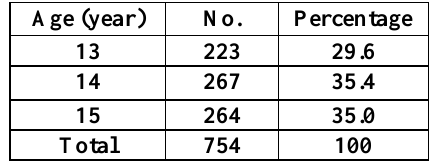
Table 1: Distribution of the total sample by age.